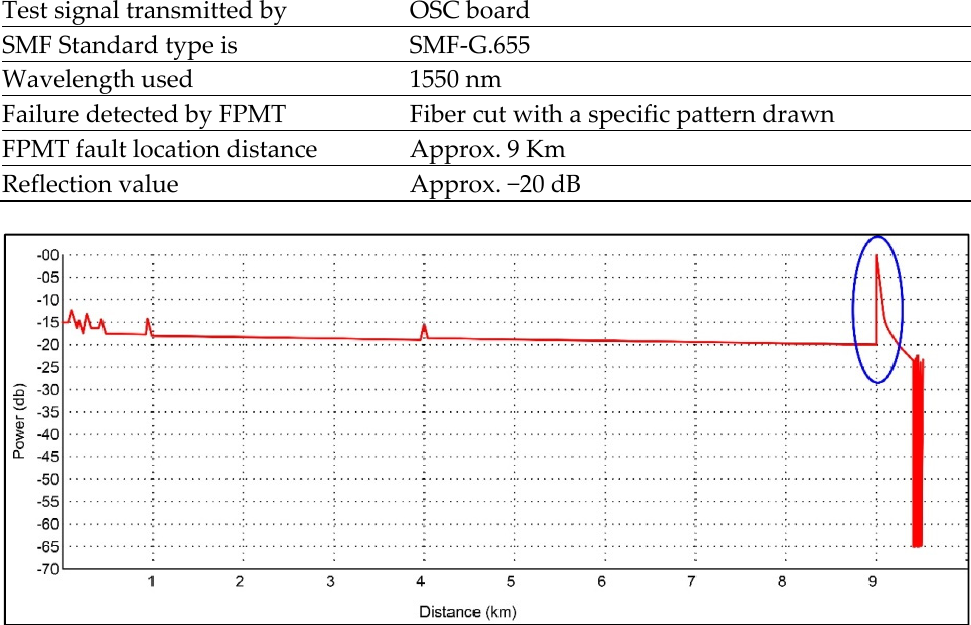
Figure 9. Fiber break event (standard SMF G.655 at 1550 nm was used and FPMT test signal was transmitted by the OSC board).